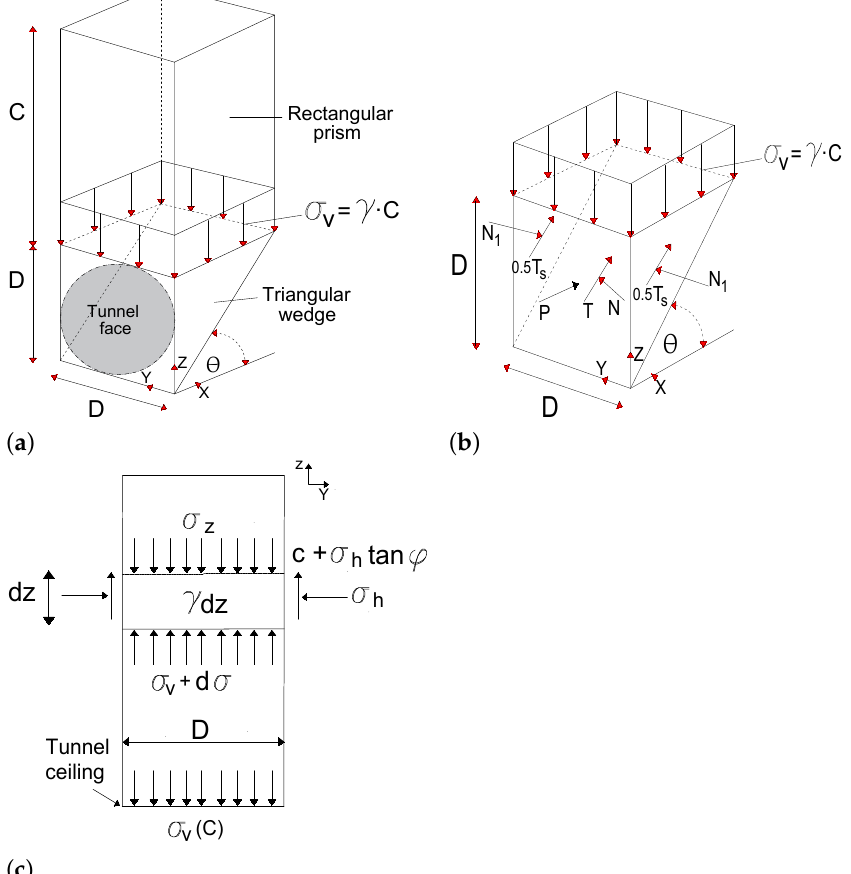
Figure 1. 3D limit equilibrium model ( a ) Horn’s failure mechanism ( b ) Forces acting on the wedge ( c ) A strip of soil in arching